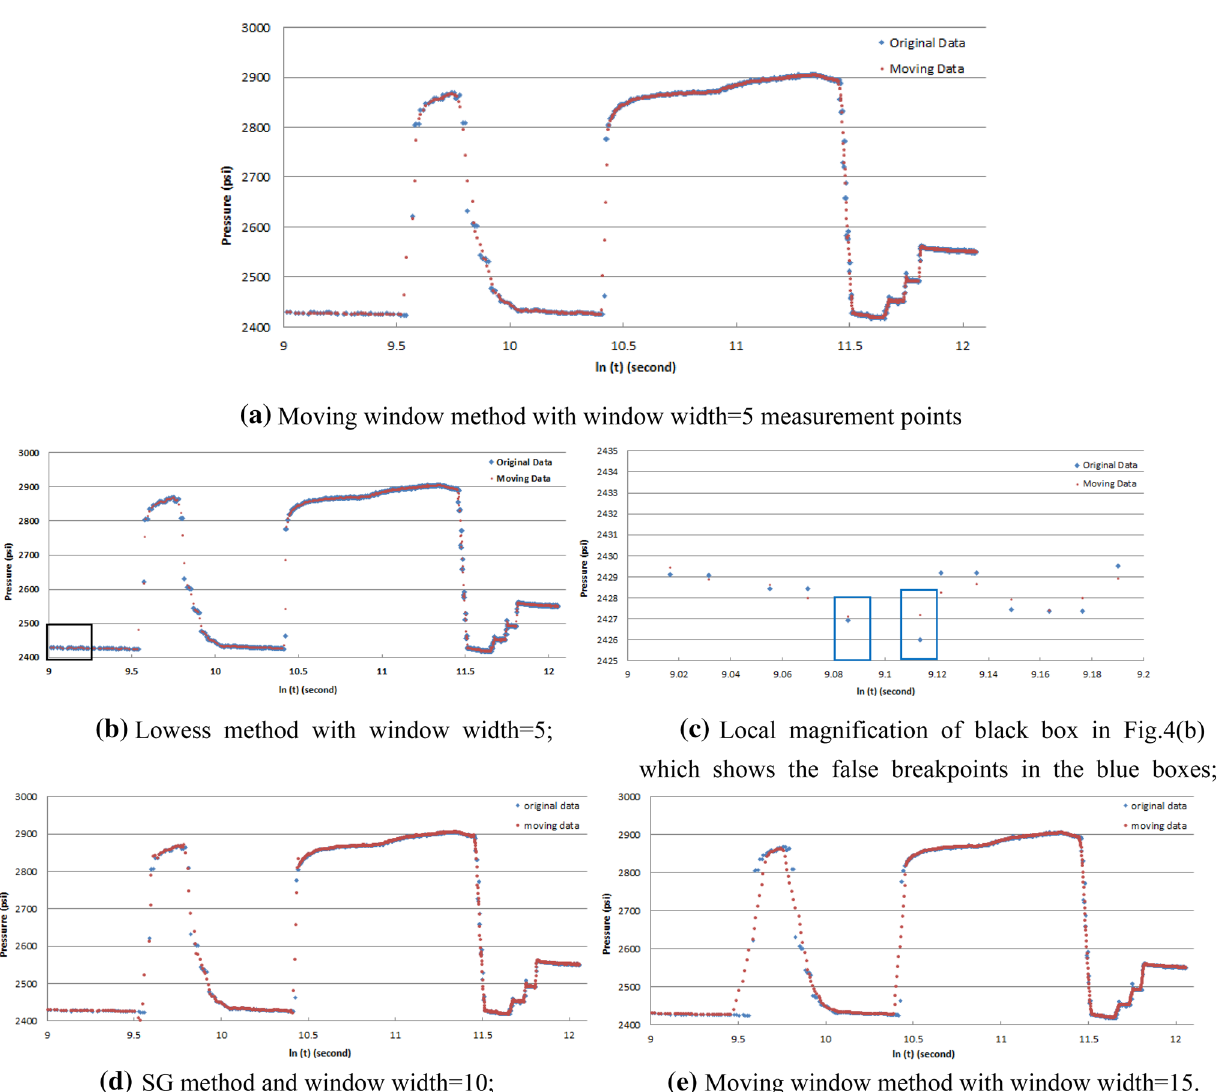
Fig. 5 Results of different smoothing methods. a Moving win- dow method with window width = 5 measurement points. b Lowess method with window width = 5. c Local magnification of black box